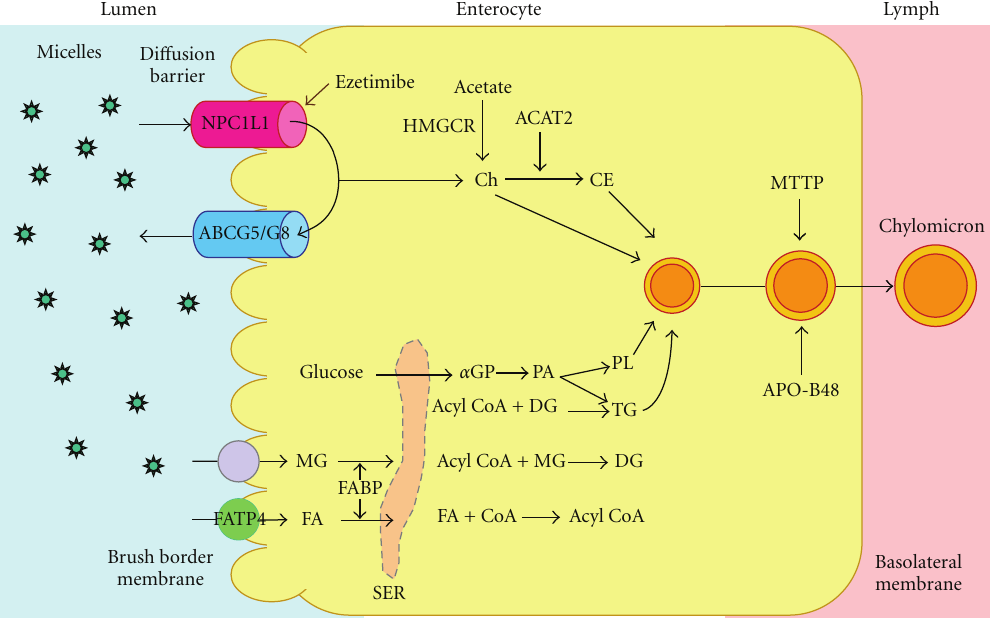
Figure 1: Within the intestinal lumen, the micellar solubilization of sterols facilitates movement through the di ff usion barrier overlying the surface of the absorptive cells. In the presence of bile acids, large amounts of the sterol molecules are delivered to the aqueous-membrane interface so that their uptake rate is greatly increased. The Niemann-Pick C1-like 1 protein (NPC1L1), a newly identified sterol influx transporter, is located at the apical membrane of the enterocyte and may actively facilitate the uptake of cholesterol and plant sterols by promoting the passage of these molecules across the brush border membrane of the enterocyte. In contrast, ABCG5/G8 promote active e ffl ux of cholesterol and plant sterols from the enterocyte into the intestinal lumen for excretion. The combined regulatory e ff ects of NPC1L1 and ABCG5/G8 play a critical role in modulating the amount of cholesterol that reaches the lymph from the intestinal lumen. Ezetimibe may reduce cholesterol uptake by the enterocytes through the NPC1L1 pathway, possibly a transporter-facilitated mechanism. Absorbed cholesterol as well as some that is newly synthesized from acetate by 3-hydroxy-3-methylglutaryl-CoA reductase (HMGCR) within the enterocyte is esterified by acyl-CoA:cholesterol acyltransferase isoform 2 (ACAT2) to form cholesteryl esters. It is likely that fatty acids (FA) and monoacylglycerol (MG) could be taken up into enterocytes by facilitated transport. With the assistance of fatty acid binding protein 4 (FABP4), fatty acids and monoacylglycerol are transported into the smooth endoplasmic reticulum (SER) where they are used for the synthesis of diacylglycerol (DG) and then triacylglycerol (TG). Glucose is transported into the SER for the synthesis of phospholipids (PL) through the phosphatidic acid (PA) pathway (abbreviation: α -GP, α -glycerophosphate). All of these lipids participate in the formation of chylomicrons, a process which also requires the synthesis of apolipoprotein (APO)-B48 and the activity of microsomal triglyceride transfer protein (MTTP). As observed in lymph, the core of the secreted chylomicrons contains triglycerides and cholesteryl esters and the surface of the particles is a monolayer containing phospholipids, mainly phosphatidylcholine, unesterified cholesterol and apolipoproteins including APO-B48, APO-AI, and APO-AIV. Therefore, intestinal cholesterol absorption is a multistep process that is regulated by multiple genes. Reproduced with modifications and with permission from